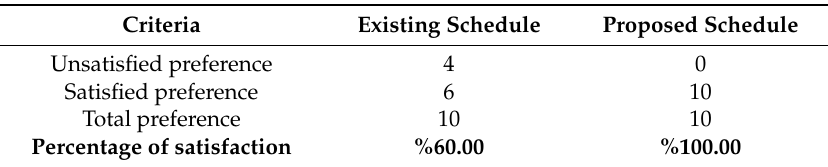
Table 6. Computational